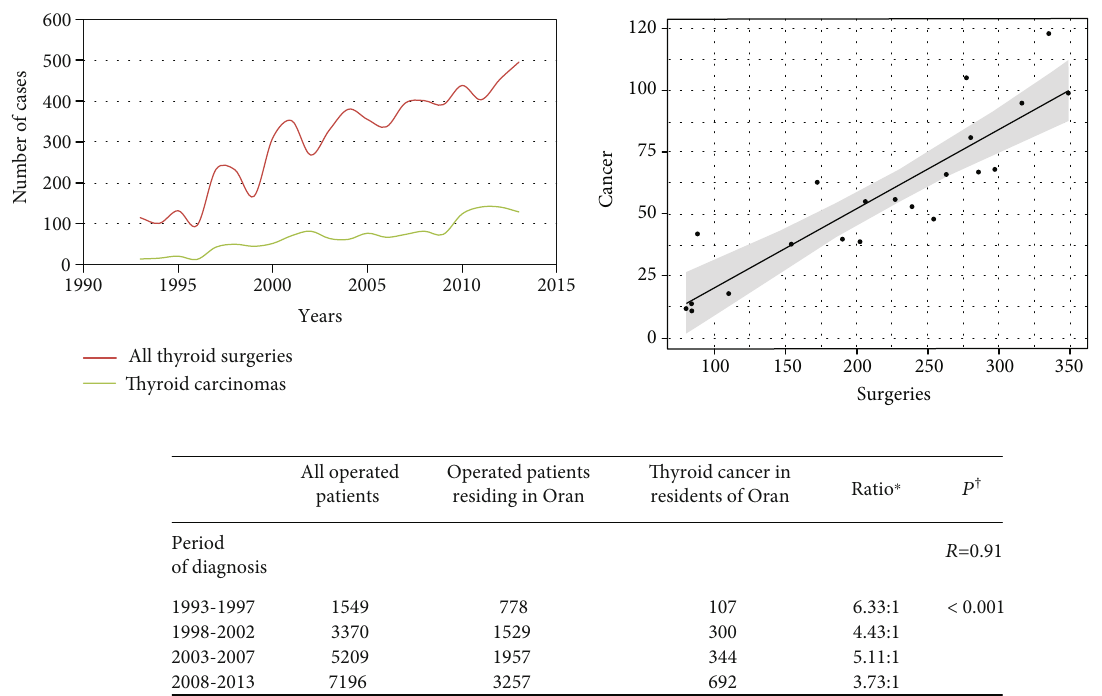
692 3.73:1 ⁎ Number of patients residing in Oran who underwent thyroid surgery in a given time period/number of patients diagnosed with thyroid cancer during the same time period ; † p for Figure 1: Trends of thyroid surgeries performed among residents of Oran, 1993-2013.